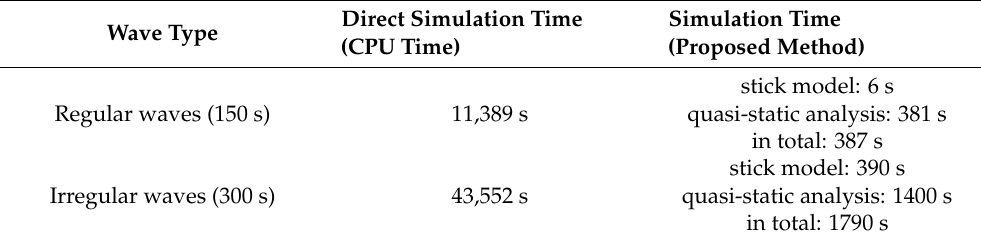
Table 5. Comparison of computational cost for the proposed method and direct simulations in